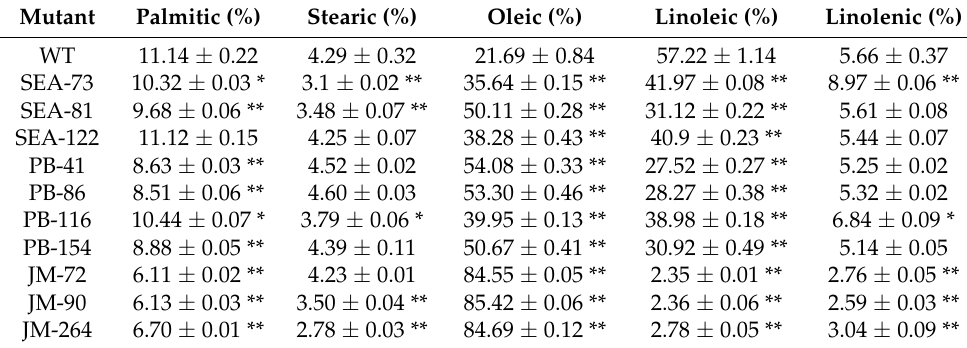
Table 2. Fatty acid profiles in different homozygous